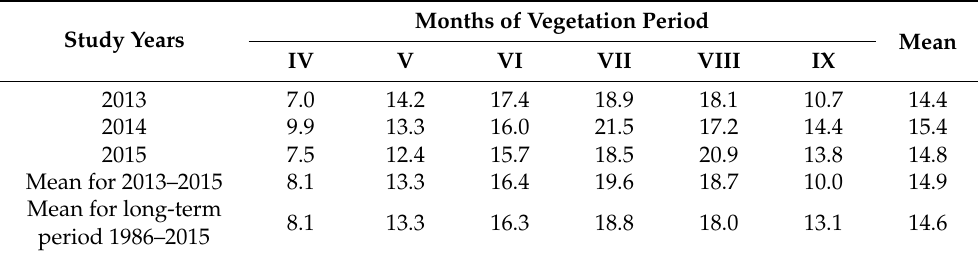
Table 1. Average air temperature ( ◦ C) data during the vegetation period of Melba and Seledyn melon